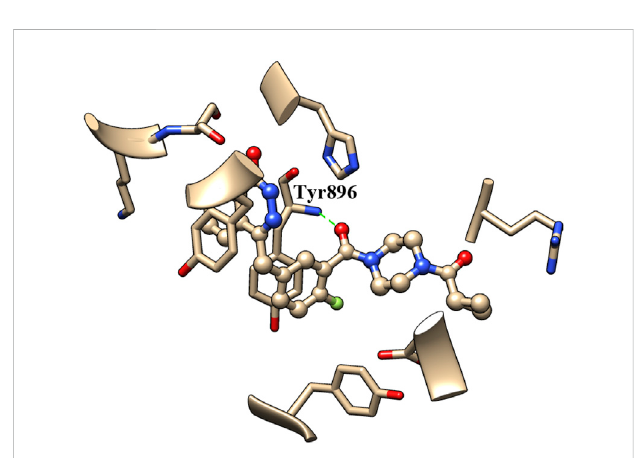
Binding pattern analysis of olaparib in the active site of